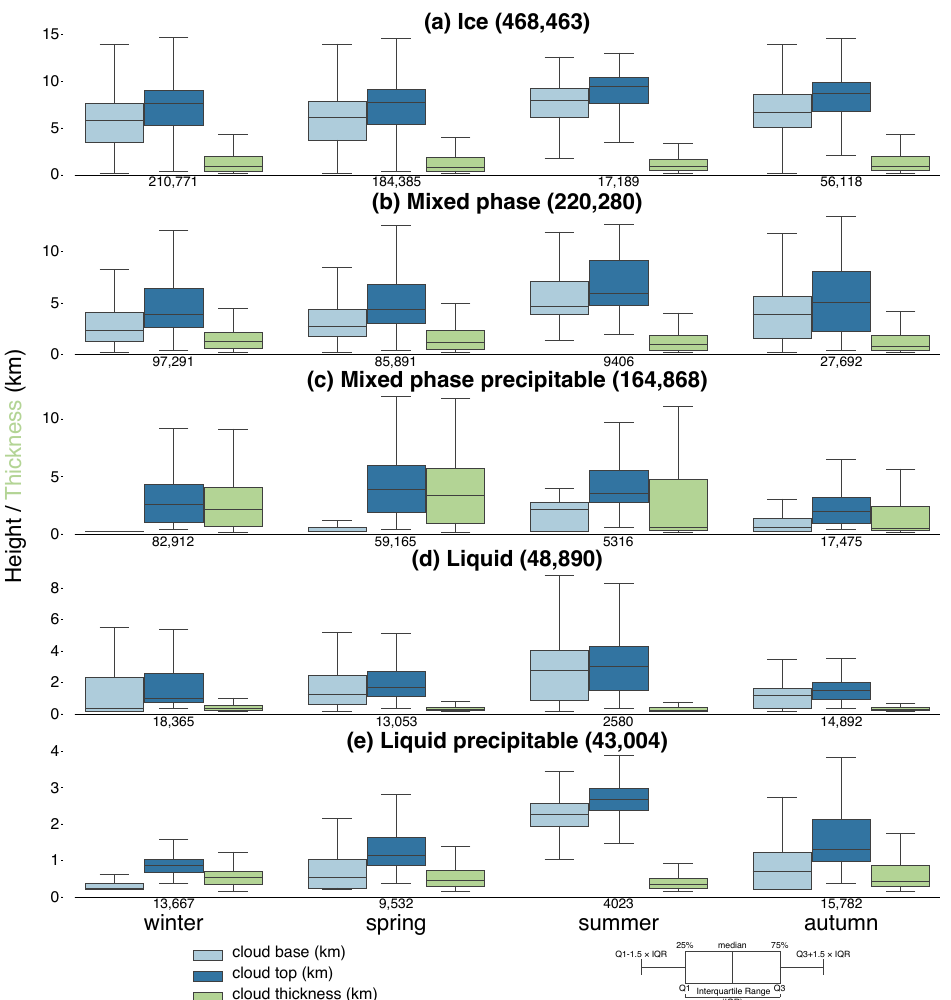
Figure 9. The seasonal occurrence of ( a ) ice, ( b ) mixed-phase, ( c ) mixed-phase precipitable, ( d ) liquid, and ( e ) liquid precipitable cloud as observed by the Bucharest–M˘agurele Cloudnet station between Dec 2019 and May 2021. For each season, the distribution of cloud base height (in km, light blue), cloud top height (in km, blue), and cloud thickness (km, green) is presented as a box-and-whiskers plot. The number in each panel represents the total number of profiles for the type of cloud and for each season. Note that the data from summer and autumn are collected for one year, and for winter and spring, the data are collected for two